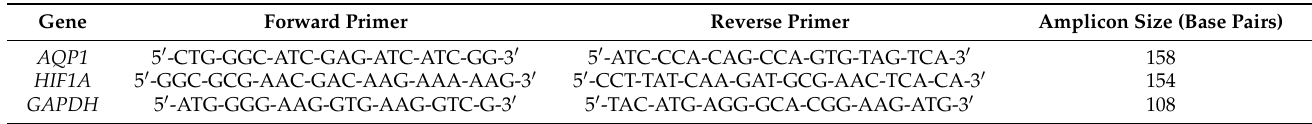
Table 3. Sequences of the primers used and the amplicon